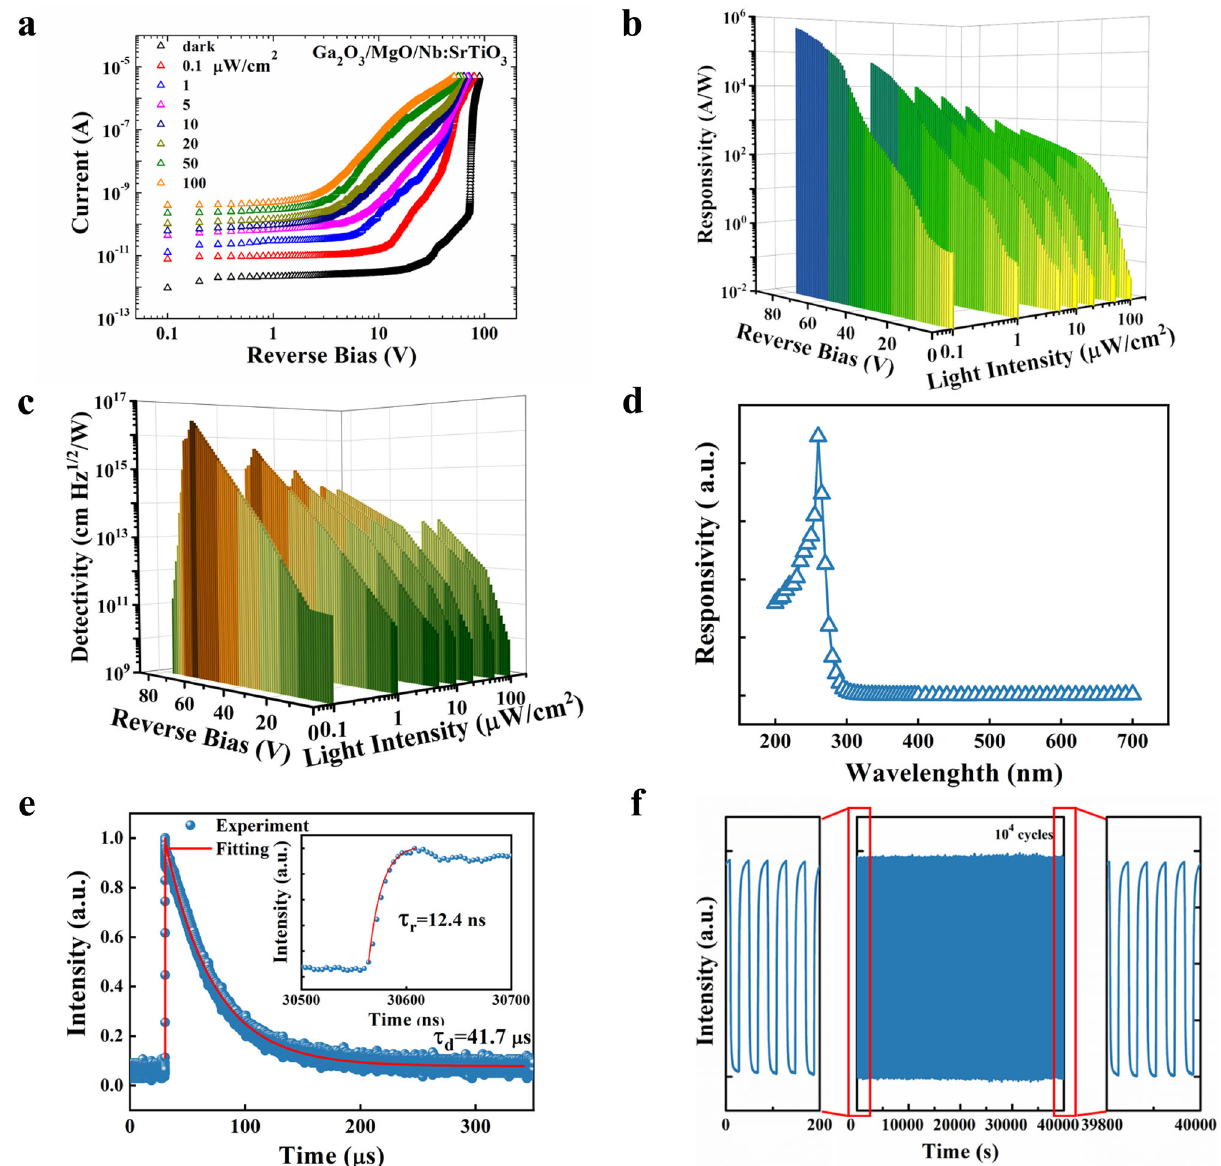
Fig. 4 | Photoresponse characteristics the nBn unipolar barrier APD. a Reverse I – V characteristics of the nBn unipolar barrier APD in the dark and under various intensities 254nm light illumination. The responsivity ( b ) and detectivity ( c ) as functions of light intensities and applied bias. d Wavelength-dependent